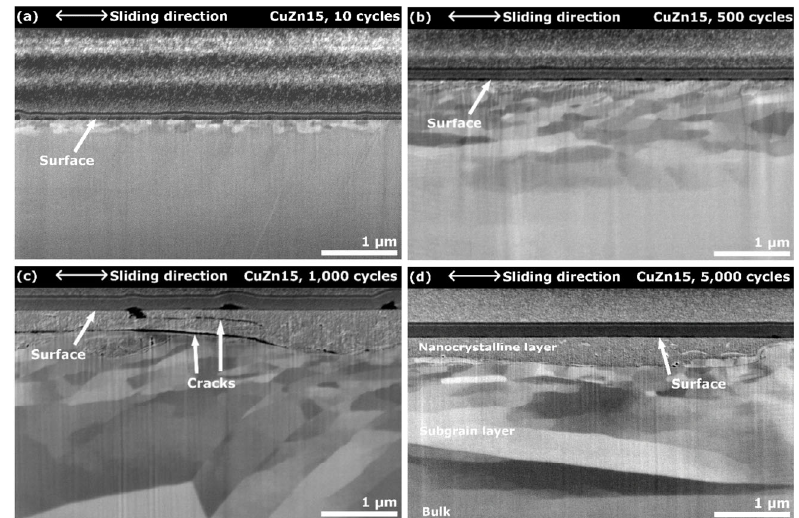
Fig. 6 Cross-sectional SEM images of the sub-surface microstructure. Microstructure evolution over different stages of sliding contact is exemplarily shown with CuZn15 (a) after 10 cycles; (b) after 500 cycles; (c) after 1,000 cycles, cracks are marked by white arrows; (d) after 5,000 cycles. The cross-sections were prepared in the center of the wear tracks, along the sliding direction (shown as the white double arrow in the images). Sample surfaces are marked by white arrows.